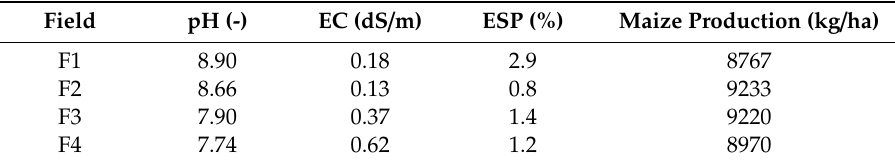
Table 7. Soil pH, EC, ESP and maize production after harvest in high-production plots (more than 8000 kg / ha) in F1, F2, F3, and